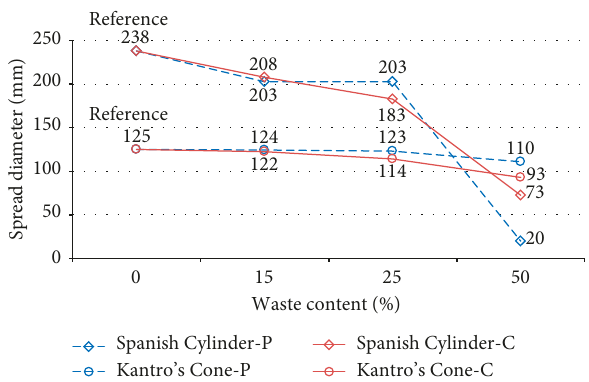
Figure 7: SLM spread diameter results. P: porcelain waste; C: ceramic waste.